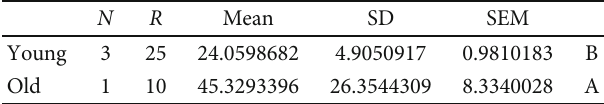
Table 2: E ff ect of age in population doubling time (PDT). N R Mean SD